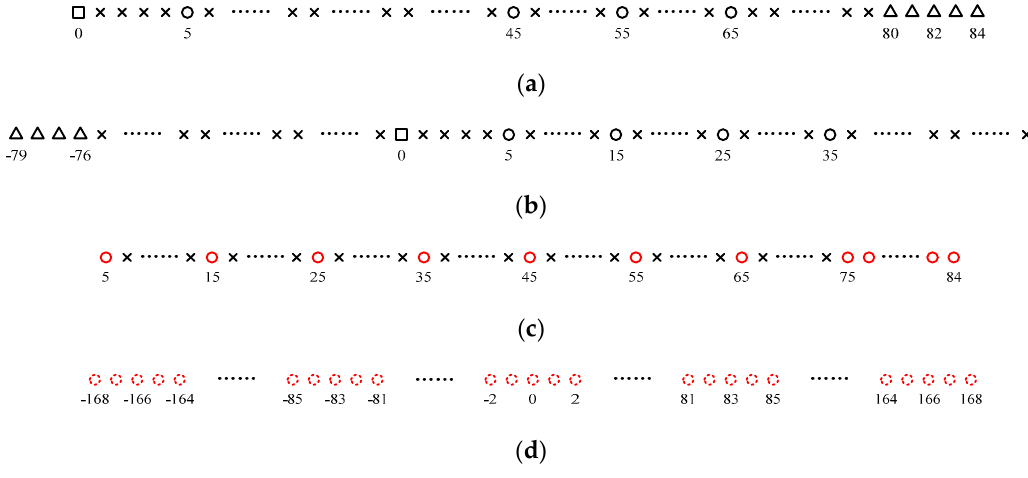
Figure 2. Two examples of novel nested arrays NNA-I and NNA-IV, where N = 10. ( a ) The physical structure of NNA-I. ( b ) The physical structure of NNA-IV. ( c ) The equivalent received array of NNA-I and NNA-IV. ( d ) The final sum-di ff erence coarray (SDCA), which is fully continuous and its number of continuous degrees of freedom (DOFs) is equal to 337. Black squares represent the sensors with zero location in NNA-I and NNA-IV, while black triangles and circles indicate sensors of S 1, a and S 2, a in NNA-I and NNA-IV, respectively. Red circles stand for virtual sensors in equivalent received array of NNA-I and NNA-IV, while red dotted circles denote the virtual sensors in